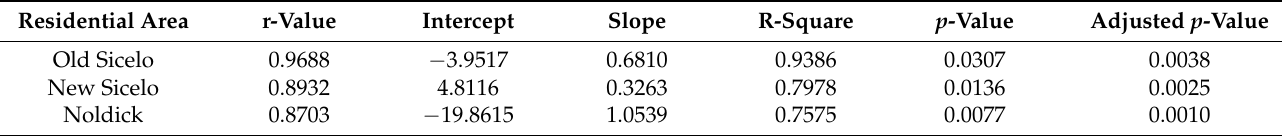
Table 2. Correlation and regression between indoor and outdoor PM 2.5 mass concentrations for the three residential areas. Residential